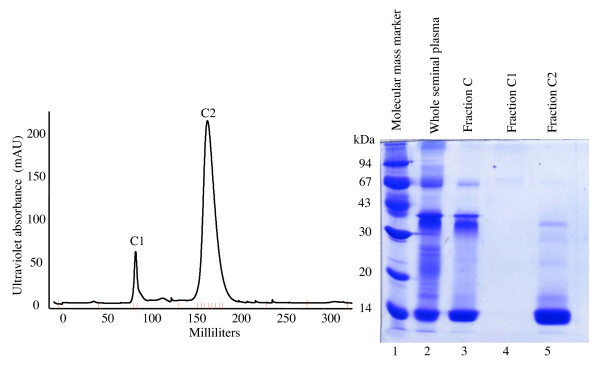
Separation of protein Fraction C of llama seminal plasma. Separation was done using sephacryl gel filtration fast protein liquid chromatography (FPLC) and isocratic elution with phosphate buffered saline (left). Fraction C was isolated previously by hydroxylapatite gravity column chromatography. Vertical lines along the x-axis represent fractions collected and examined. The protein band at about 14 kDa on denaturing 12% SDS-PAGE (right) was the major constituent of Fraction C2 (right).